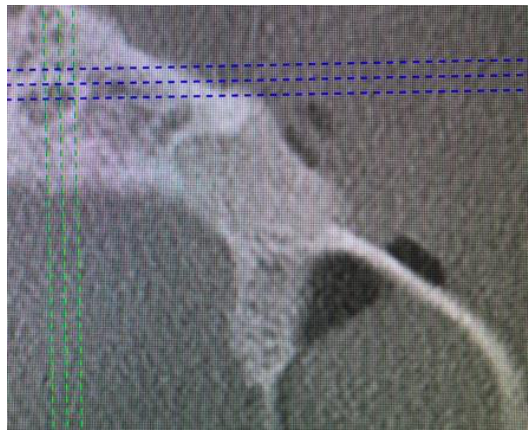
Figure 7. CBCT axial view directly after surgery to evaluate buccal bone plate restoration.